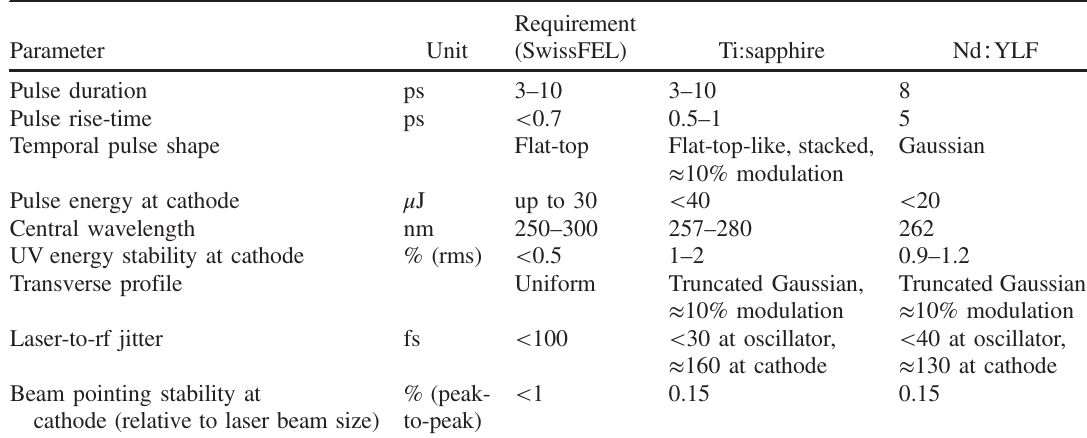
TABLE III. SwissFEL gun laser requirements and achieved performance of the Ti ∶ sapphire and Nd ∶ YLF amplifier systems used at the SITF.